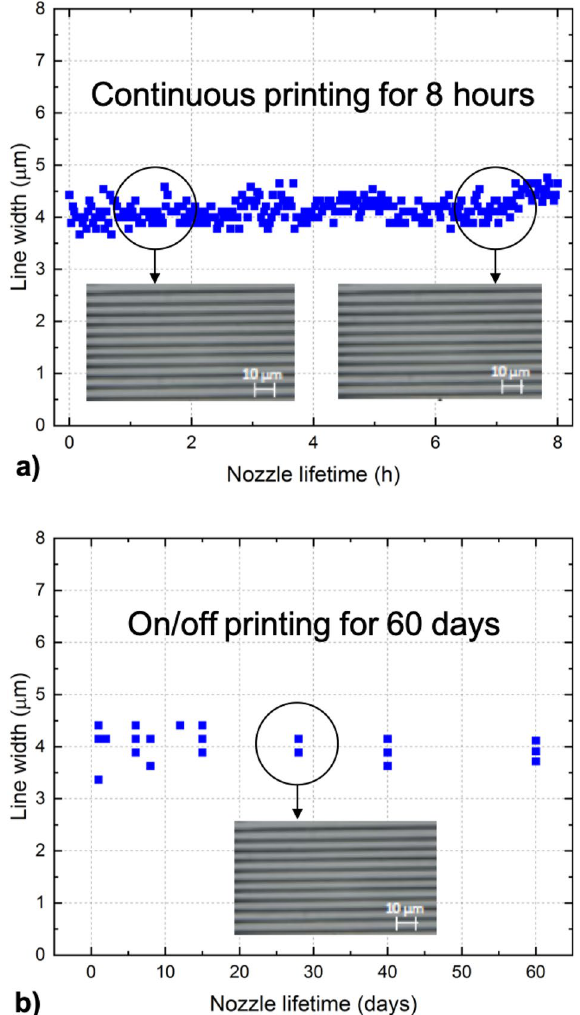
Figure 10. Stability tests performed for silver nanopaste and a single printing nozzle with the diameter of 2.5 µm. ( a ) continuous printing for 8 h; ( b ) on and off printing for 60 days. The scale bar in the images corresponds to 10